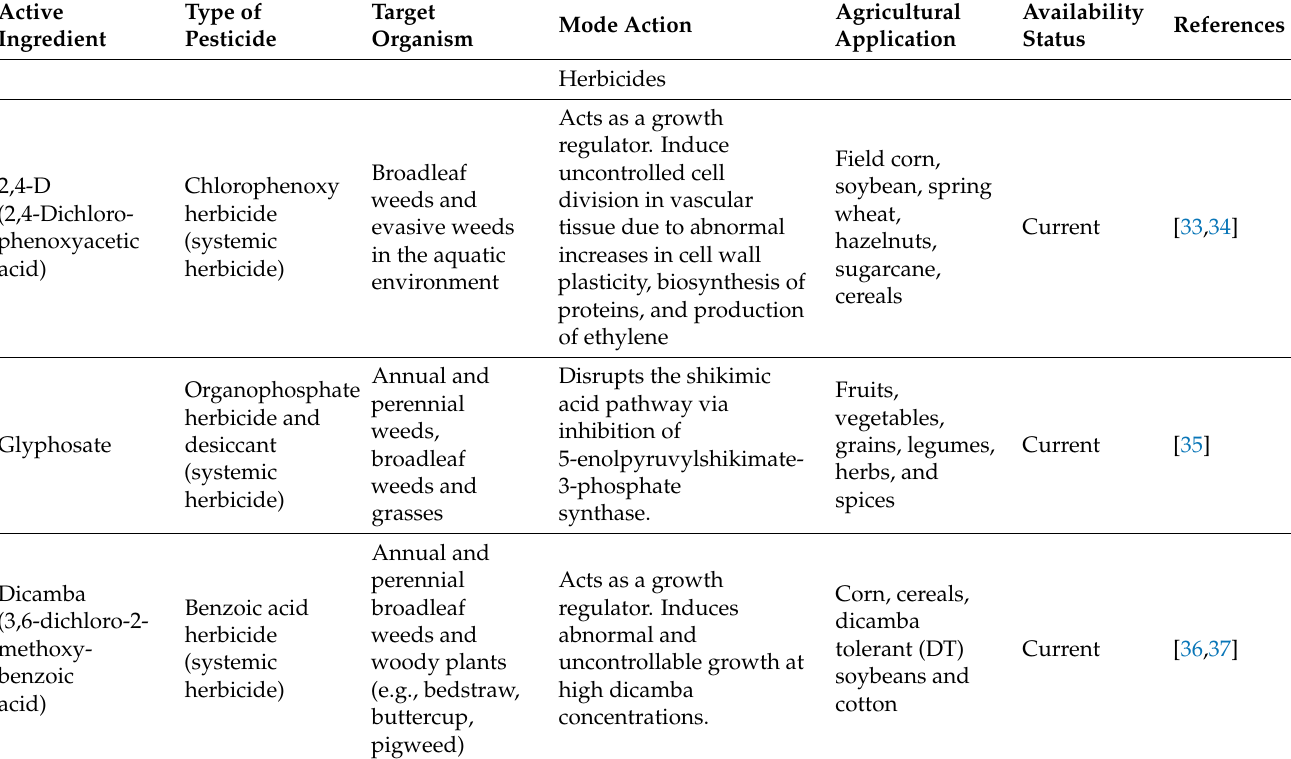
Table 1. Example of pesticides from three main categories—herbicides, insecticides, and fungicide with their target organism and mode of